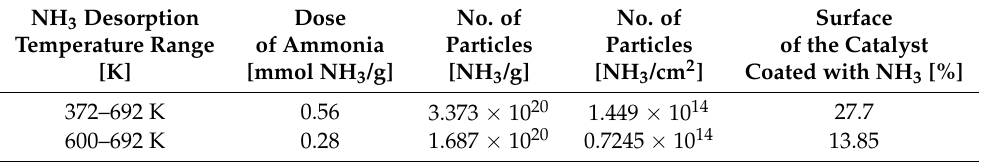
Table 1. Results of determination of acidity of the surface of the converter’s carrier. NH 3